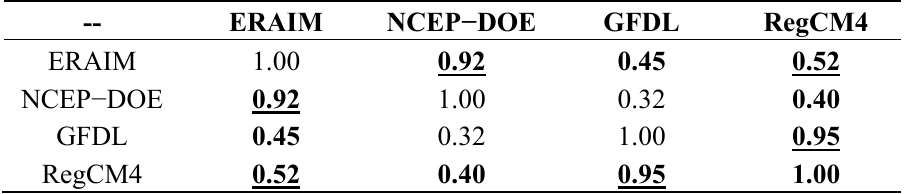
Table 1. Matrix of Correlation coefficients between ERAIM, NCEP − DOE, GFDL and RegCM4 datasets of wind speed at 200 hPa, at confidence level of 95% and 99%.